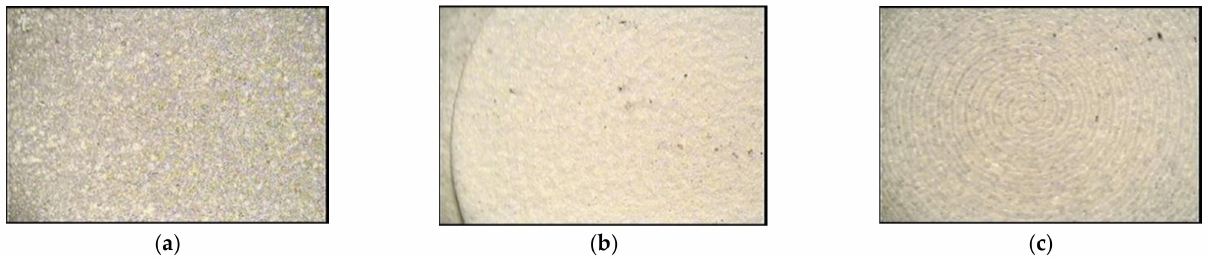
Figure 2. Imaging of the Al 2 O 3 /glass–ceramic composite coating, treated with different power densities of CO 2 laser irradiation: ( a ) without irradiation, ( b ) 0.69 W/cm 2 and ( c ) 1.04 W/cm 2